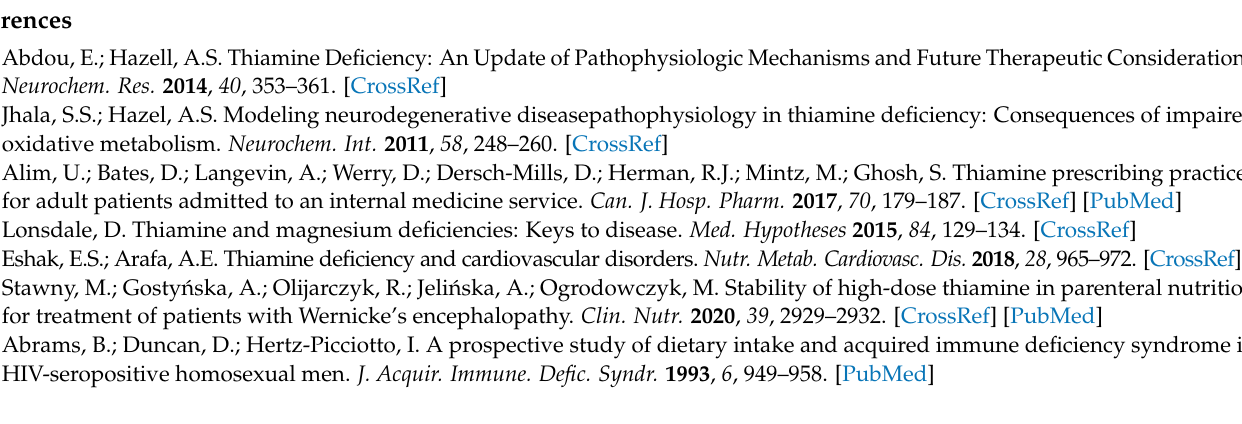
EGC, Table S5: Chelating properties to samples with thiamine hydrochloride and ECG, Table S6: Chelating properties to samples with thiamine pyrophosphate and ECG, Table S7: Chelating proper- ties to samples with thiamine hydrochloride and caffeine, Table S8: Chelating properties to samples with thiamine pyrophosphate and caffeine, Table S9: Reducing power to samples with thiamine hydrochloride and EGCG, Table S10: Reducing power to samples with thiamine pyrophosphate and EGCG, Table S11: Reducing power to samples with thiamine hydrochloride and EGC, Table S12: Reducing power to samples with thiamine pyrophosphate and EGC, Table S13: Reducing power to samples with thiamine hydrochloride and ECG, Table S14: Reducing power to samples with thiamine pyrophosphate and ECG, Table S15: Reducing power to samples with thiamine hydrochloride and caffeine, Table S16: Reducing power to samples with thiamine pyrophosphate and caffeine, Table S17: DPPH scavenging properties to samples with thiamine hydrochloride and EGCG, Table S18: DPPH scavenging to samples with thiamine pyrophosphate and EGCG, Table S19: DPPH scaveng- ing to samples with thiamine hydrochloride and EGC, Table S20: DPPH scavenging to samples with thiamine pyrophosphate and EGC, Table S21: DPPH scavenging to samples with thiamine hydrochloride and ECG, Table S22: DPPH scavenging to samples with thiamine pyrophosphate and ECG, Table S23: DPPH scavenging to samples with thiamine hydrochloride and caffeine, Table S24: DPPH scavenging to samples with thiamine pyrophosphate and caffeine, Table S25: ABTS scaveng- ing to samples with thiamine hydrochloride and EGCG, Table S26: ABTS scavenging to samples with thiamine pyrophosphate and EGCG, Table S27: ABTS scavenging to samples with thiamine hydrochloride and EGC, Table S28 ABTS scavenging to samples with thiamine pyrophosphate and EGC, Table S29: ABTS scavenging to samples with thiamine hydrochloride and ECG, Table S30: ABTS scavenging to samples with thiamine pyrophosphate and ECG, Table S31: ABTS scavenging to samples with thiamine hydrochloride and caffeine, Table S32. ABTS scavenging to samples with thiamine pyrophosphate and